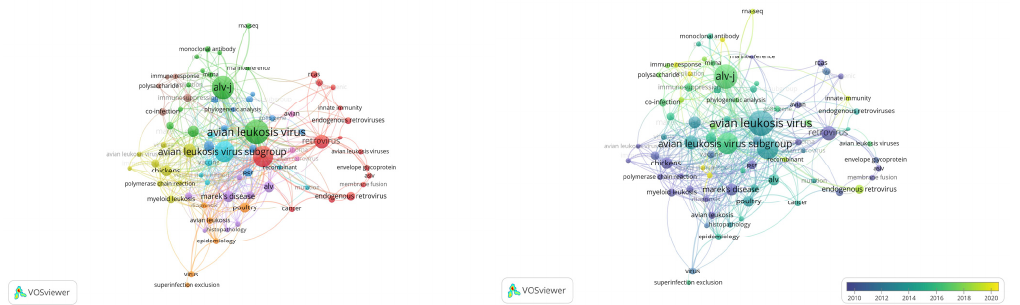
Figure 4. Authors’ keyword analysis for latest research trends on Avian Leukosis Virus literature from VOS viewer software.